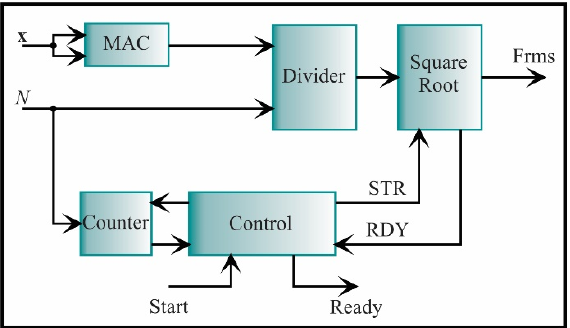
Figure 15. The architecture of the processing core for computing the RMS.